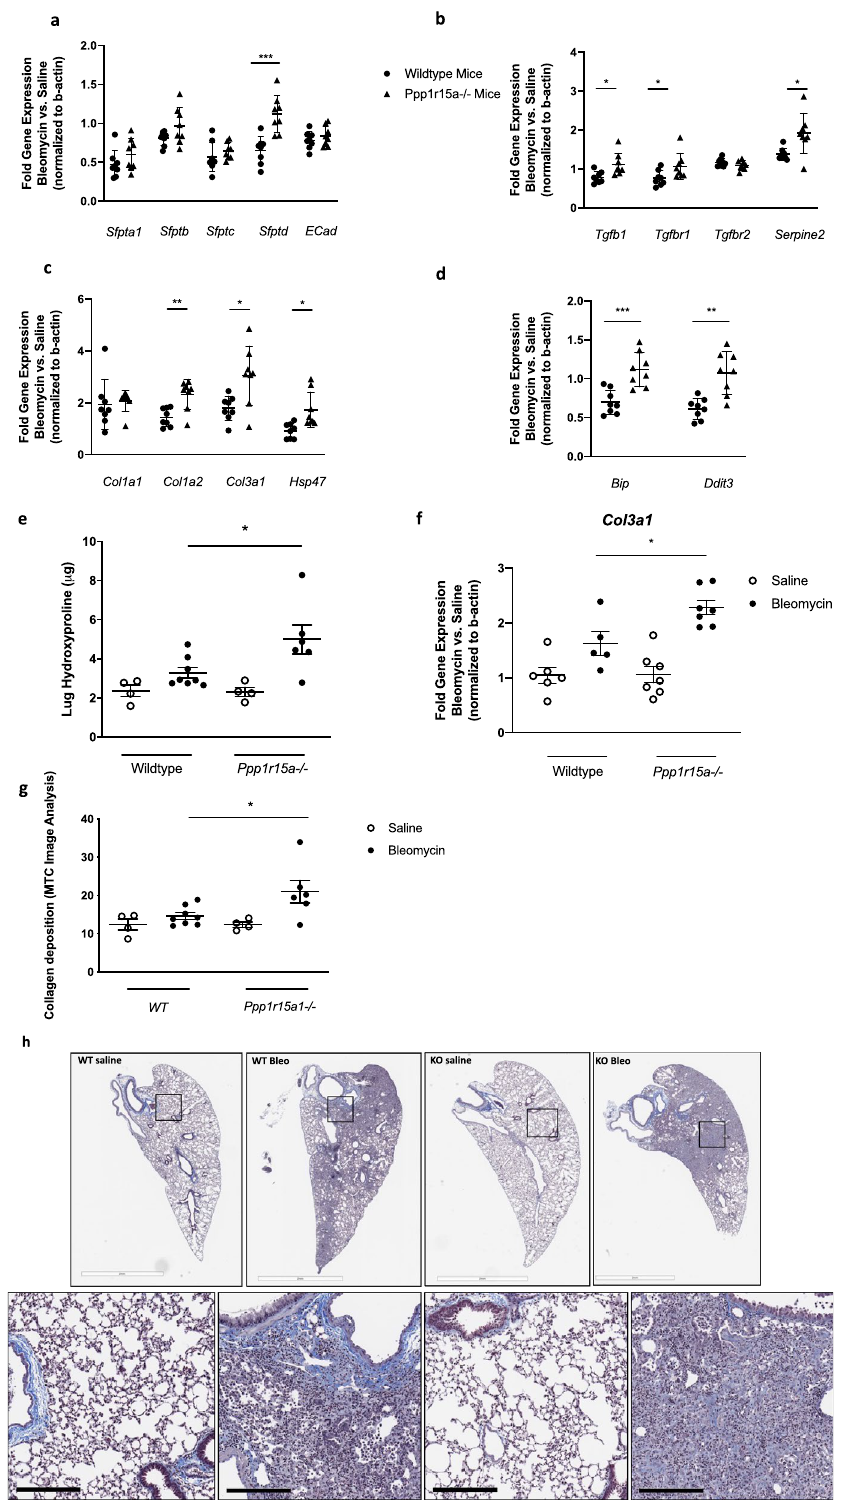
Figure 5. Loss of PPP1R15A exacerbates bleomycin-induced lung fibrosis. ( a – d ) Whole lung gene expression of epithelial genes ( a ), TGFβ- and senescence-related genes ( b ), collagen-related genes ( c ), and UPR/ER stress related genes ( d ) following oropharyngeal bleomycin administration to Ppp1r15a −/− and wildtype littermate controls at Day 5 after bleomycin administration. ( e – h ) Hydroxyproline levels in the lungs of Ppp1r15a −/− and wildtype littermate controls challenged with oropharyngeal bleomycin or saline (n = 4–7/group) measured at Day 21 and quantified by biochemical analysis ( e ), whole lung Col3a1 gene expression as measured by RT-PCR ( f ), and histological quantification of Masson’s Trichrome stained histological sections ( g ), with representative images shown in ( h ). Data shown are mean ± s.e.m. fold change in gene expression mediated by bleomycin in comparison to relevant littermate control. Data are shown as mean ± s.e.m. * P < 0.05, ** P < 0.01, *** P < 0.001 as designated or when no bars, as compared to saline control